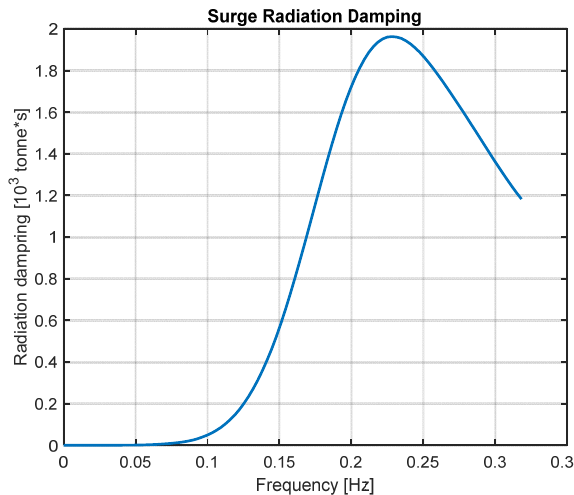
Figure 5. Radiation damping coefficient.